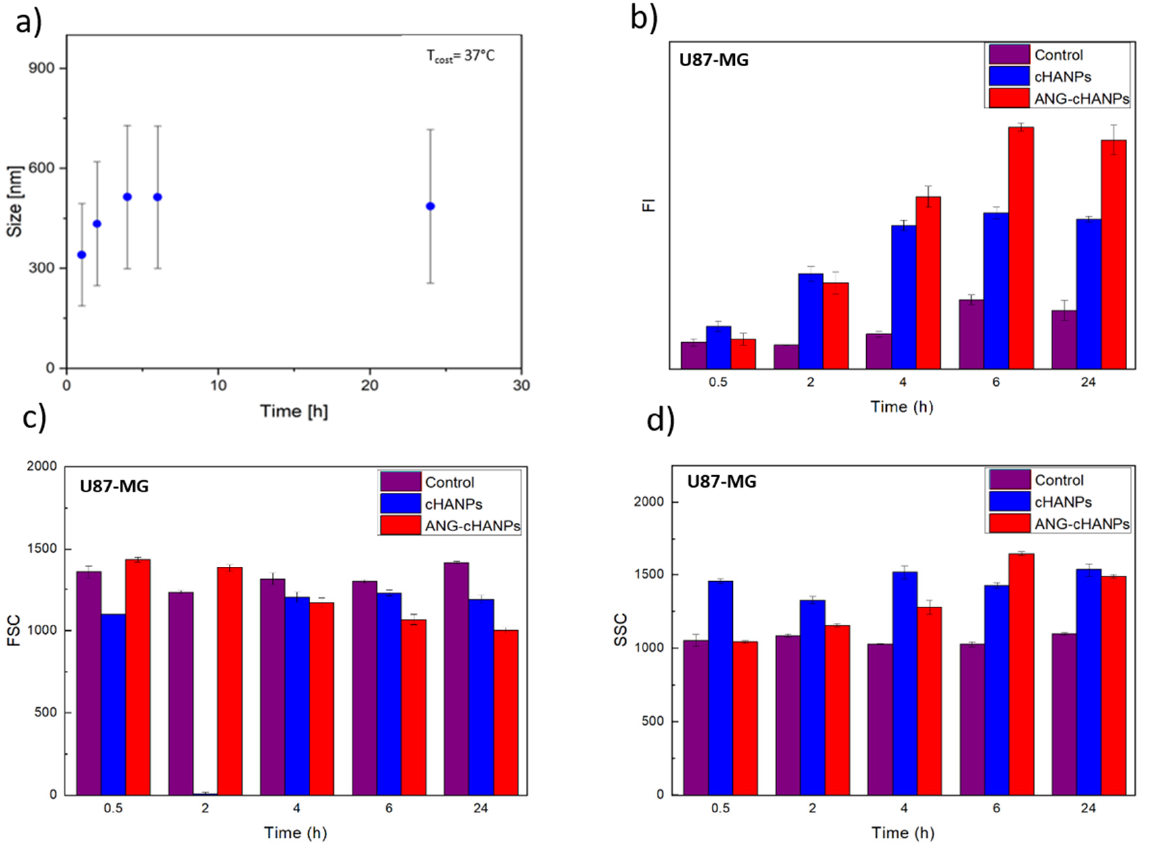
Figure 4. Quantitative uptake of nanoparticles by U87-MG cells in flow cytometry. ( a ) ANG-cHANPs stability in culture medium at 37 °C up to 24 h ( b ) Fluorescence intensity (FI) of U87 after incubation with cHANPs and ANG-cHANPs; ( c ) Forward scattering (FSC) of U87 after incubation with cHANPs and ANG-cHANPs ( d ) Side scattering (SSC) of U87 after incubation with cHANPs and ANG-cHANPs.